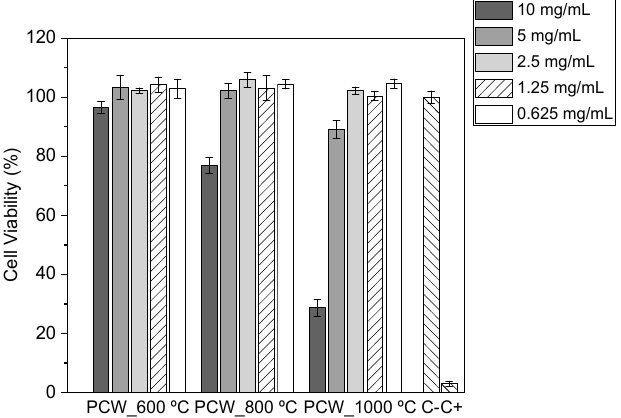
Figure 9. Cell viability in the function of powder heat treatment.